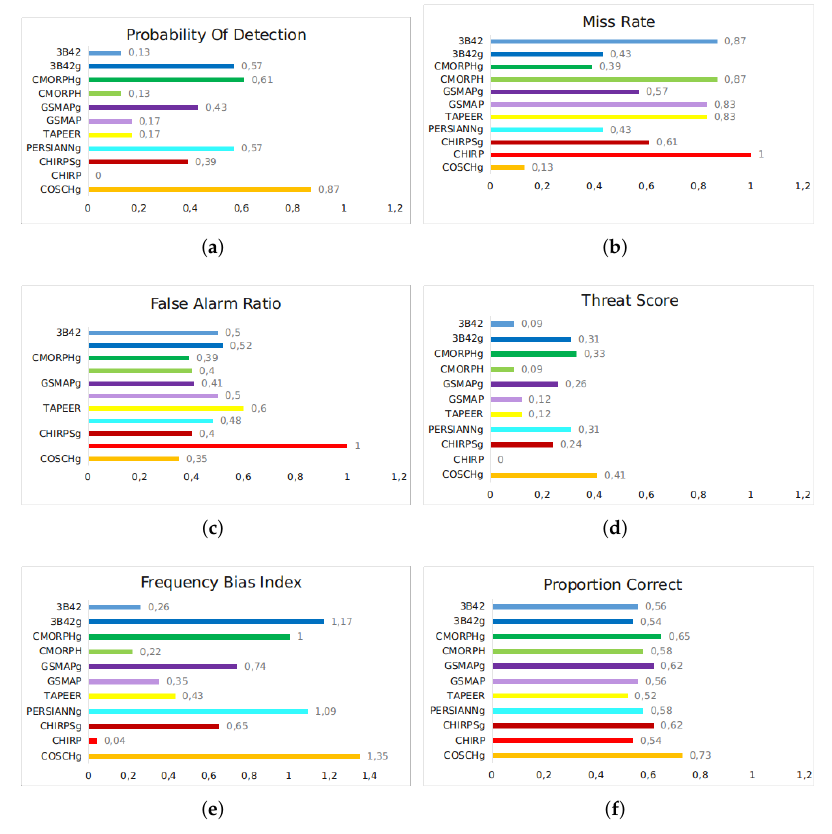
Figure 14. Bar graphs of ( a ) Probability Of Detection (POD); ( b ) Miss Rate (MR); ( c ) False Alarm Ratio (FAR); ( d ) Threat Score (TS); ( e ) Frequency Bias Index (FBI); and ( f ) Proportion Correct (PC) for